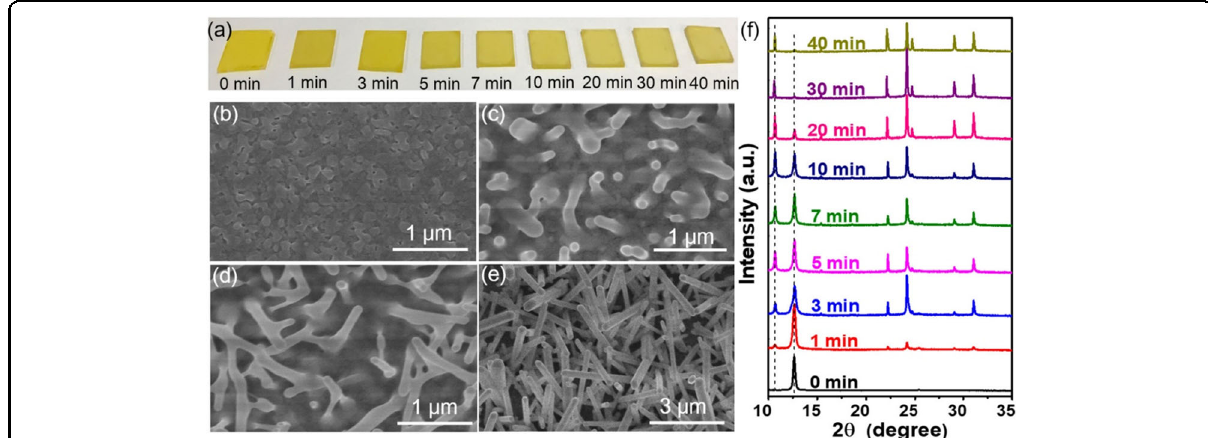
Fig. 10 Example of 1D sulfur-based (CH 3 ) 3 SPbI 3 NRs. a Optical images of PbI 2 fi lms after dipping in a (CH 3 ) 3 SI solution for different periods of time. Top-view SEM images of a PbI 2 fi lm dipped in a (CH 3 ) 3 SI solution for b 0 min, c 5 min, d 10 min, and e 30 min. f XRD patterns for the treated PbI 2 fi lms. Reproduced with permission from ref. 124 . Copyright 2020, Elsevier B.V. and Science